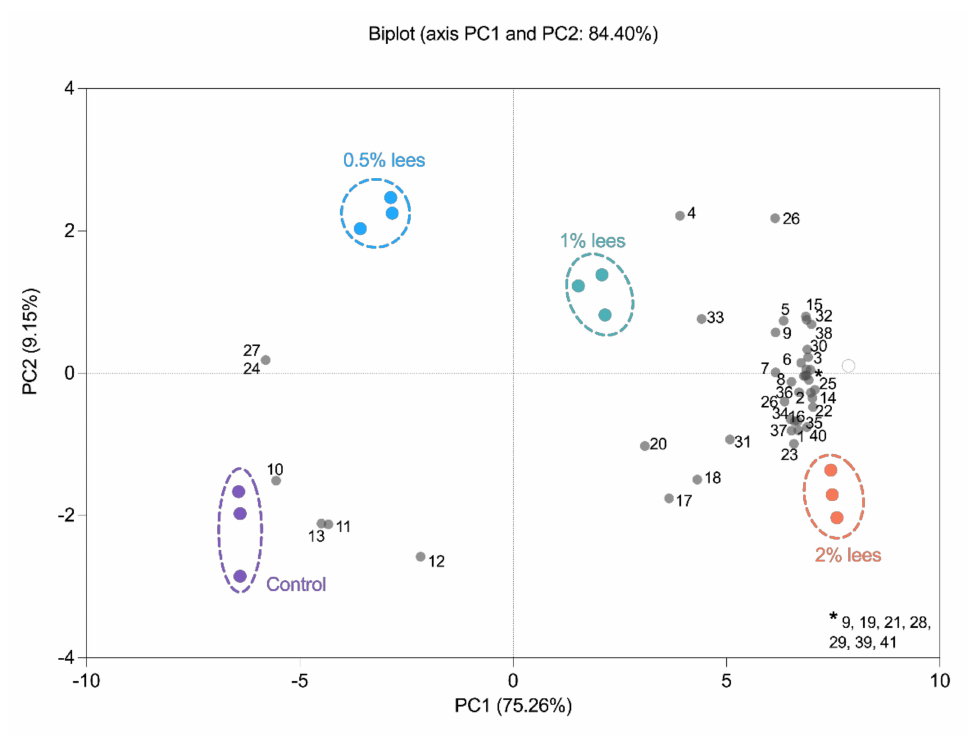
Figure 5. Principal component analysis (PCA) loadings for 41 volatile compounds (grey) and scores for the different sourdoughs at the end of the fermentation period (purple—control; blue—0.5% Cava lees; green—1% Cava lees; and orange—2% Cava lees). Numbers in loadings correspond to the volatile compounds identified in sourdoughs: 1–8 alcohols (Table 2); 9–20 acids (Table 3); 21–28 aldehydes and ketones (Table 4); and 29–41 esters (Table